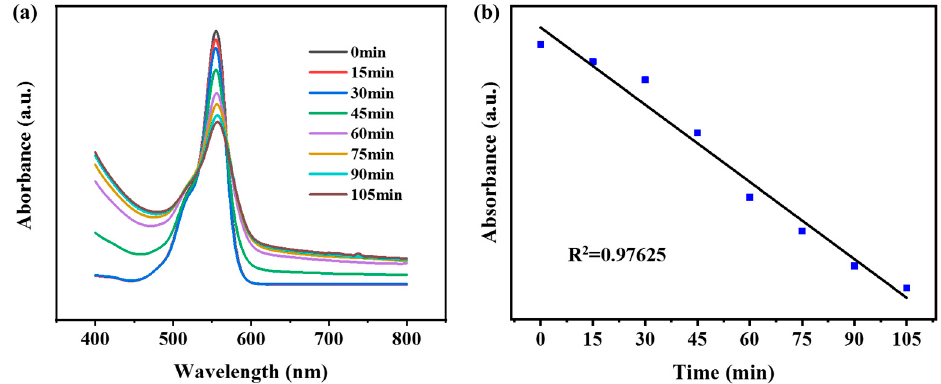
Figure 7. ( a ) UV/vis absorption spectra of RhB dye photodegradation in NIR laser with given time interval; ( b ) the linear fitting diagram of the peak at the wavelength of 553 nm.